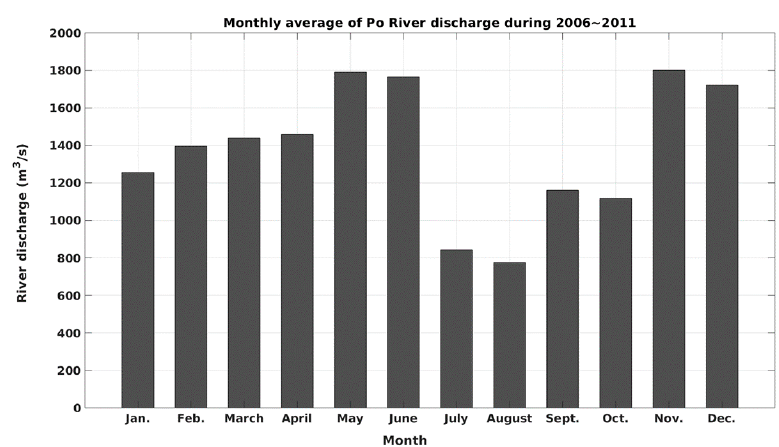
Figure 6. Monthly average of the Po River discharge during all examined years, 2006 to 2011 ( m 3